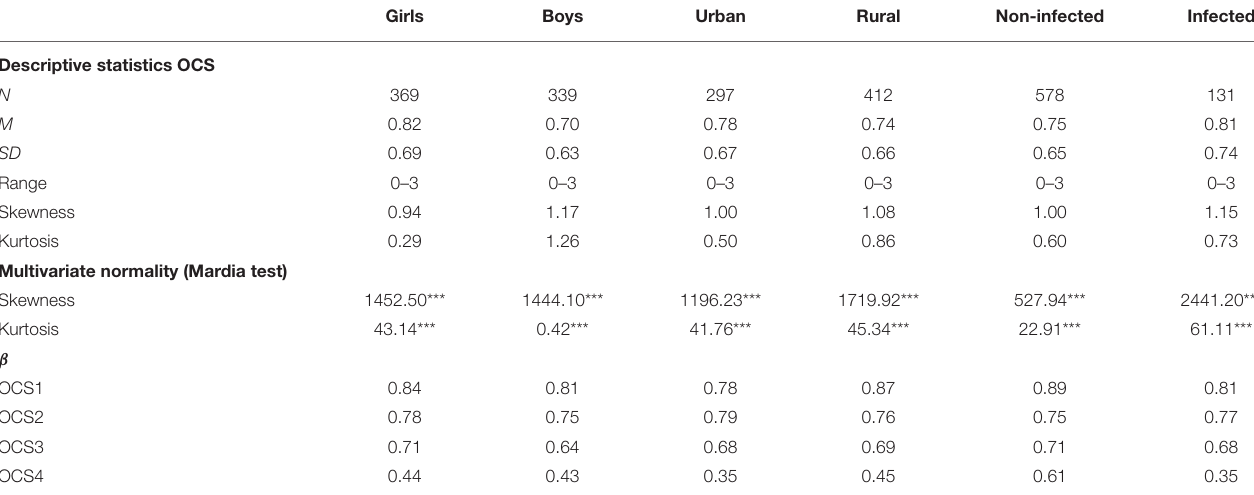
TABLE 2 | Descriptive statistics and factor loadings in